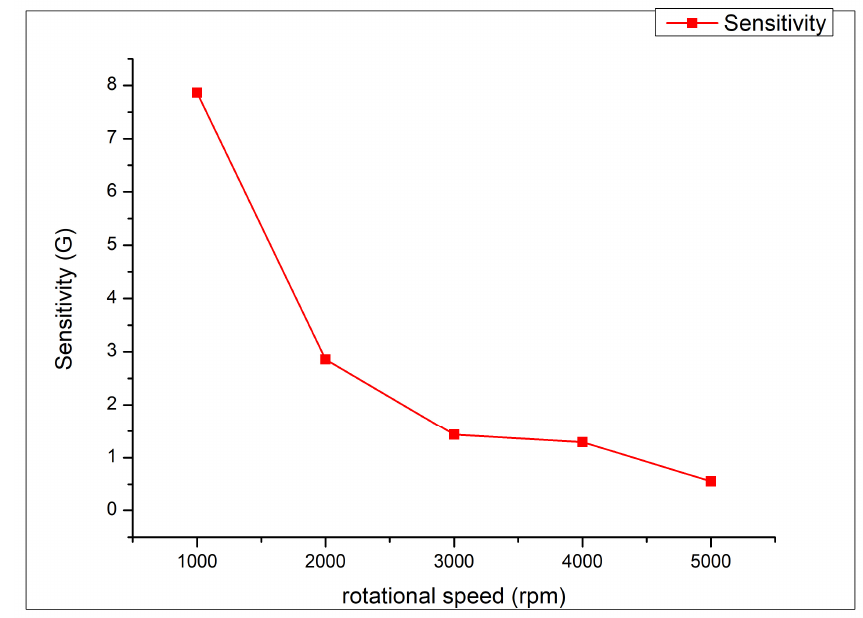
Figure 14. Sensitivity at different